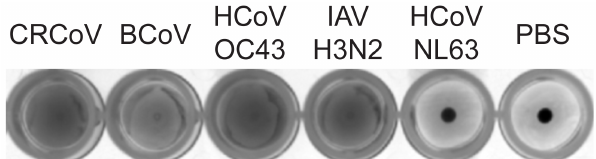
Figure 2. HCoV-OC43 VR-1558, BCoV and CRCoV agglutinate erythrocytes. Representative picture of hemagglutination assay results is shown. Mouse erythrocyte suspension was mixed with viral stocks and incubated at room temperature for 1 h. Influenza A H3N2 reported to hemagglutinate erythrocytes [36] and HCoV-NL63 which does not bind to sialic acids (SAs) [33] were used as control samples.